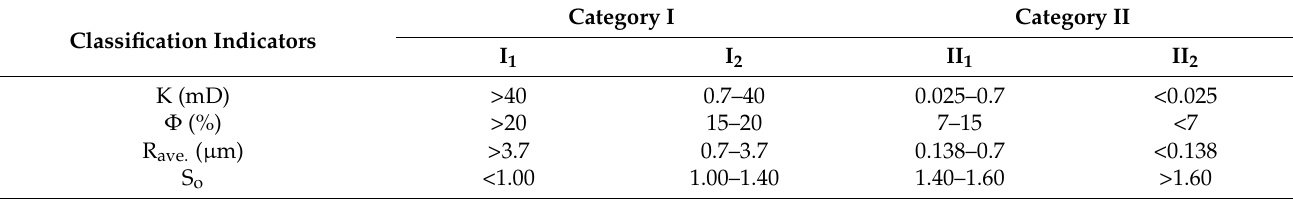
Table 2. Classification of the pore structure of the deep-mine